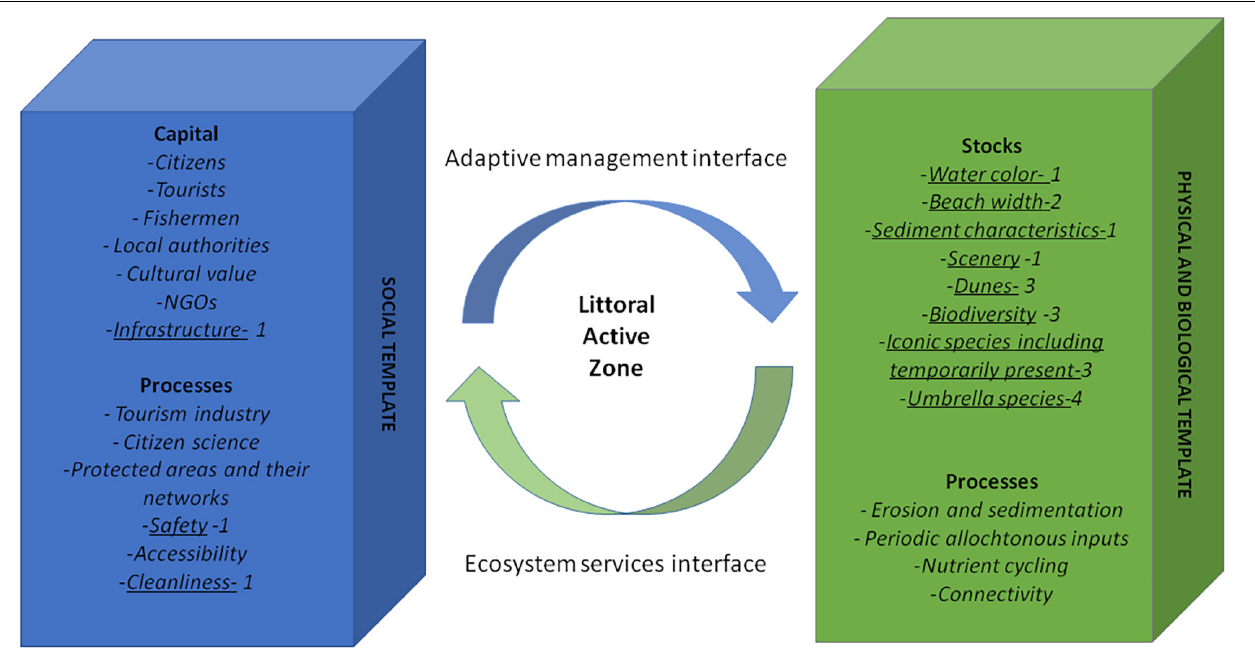
FIGURE 1 | Readapted from Fanini et al. (2020b) using the standard color-coding (blue for social template and green for the ecological template; Bretagnolle et al., 2019). Features related to attractiveness, relevance to the preservation of functionality, and easiness to report via pictures or short texts are underlined within each template. 1. Anfuso et al. (2018); identification of five main features making a beach attractive. 2. Defeo and McLachlan (2013); relevance of beach width, beach slope, and grain size to biotic processes. 3. McLachlan et al. (2013); identification of criteria for the assessment of a beach viability for conservation actions. 4. Costa and Zalmon (2021); identification of beach umbrella